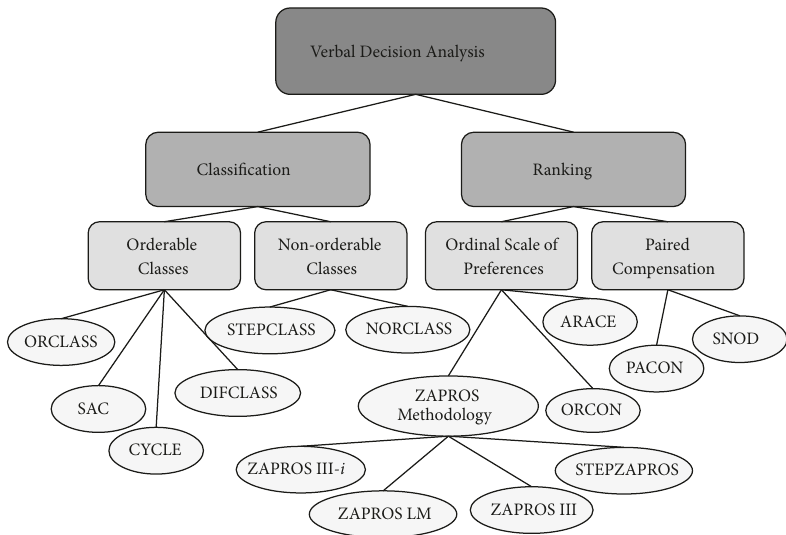
Figure 3: VDA methods for classification and ordering